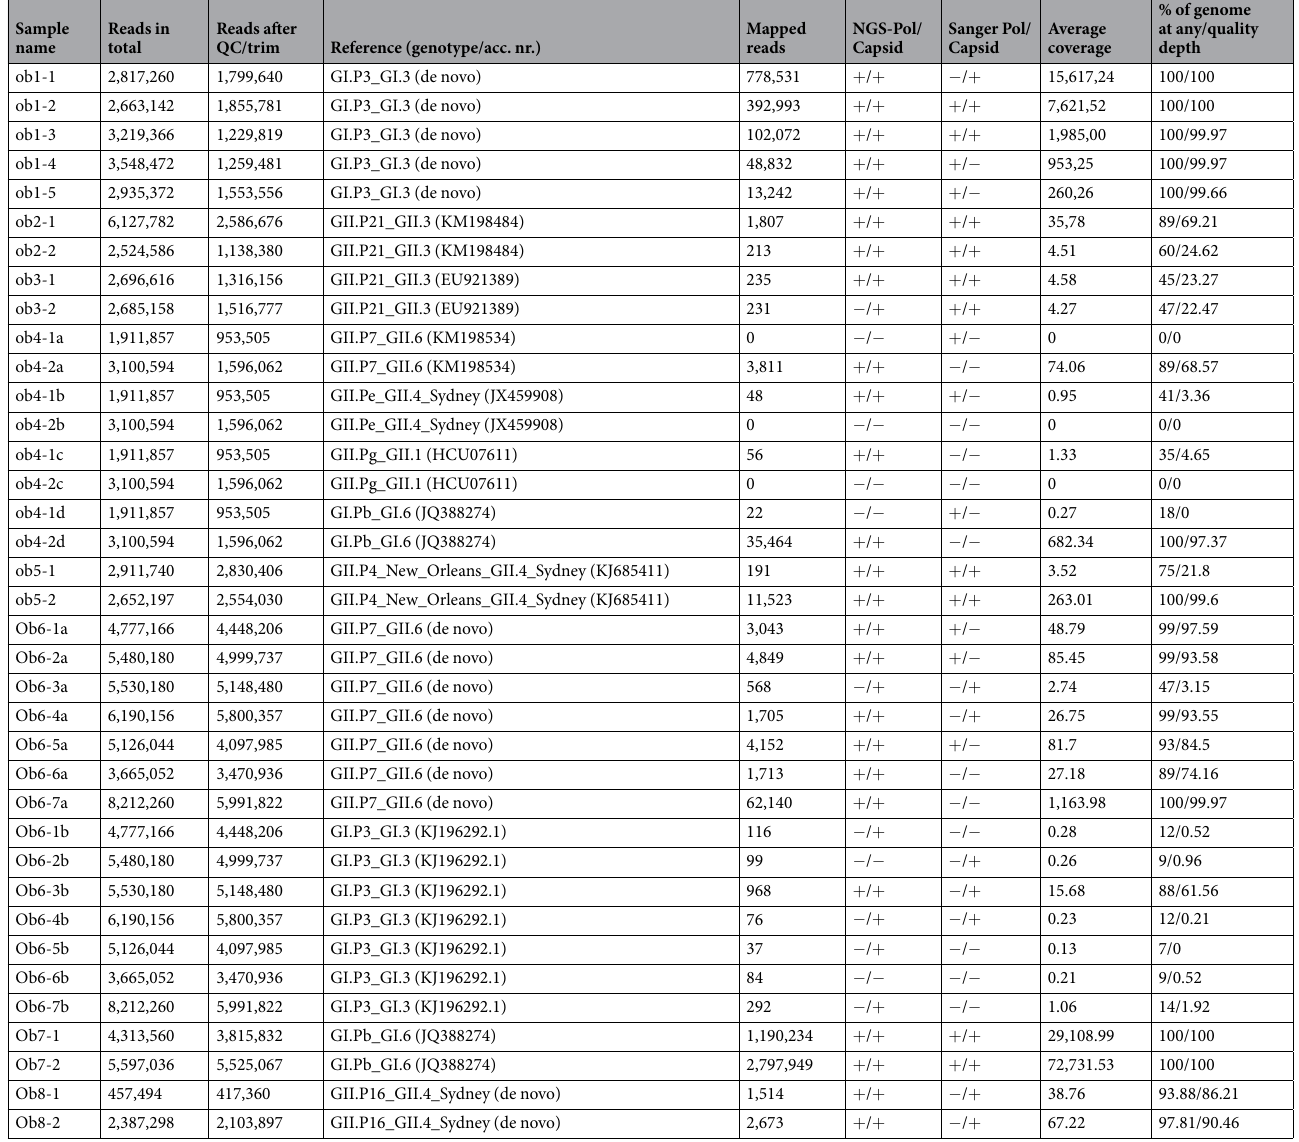
Table 2. Summary of sequencing, mapping and genotyping results of outbreak samples. Legend: Column 1: Sample name. Samples with identical numbers but different letters at the end are identical, but were mapped to different genotype reference sequence., Column 2: Total number of reads obtained before QC and trimming, Column 3: Total number of reads after quality trimming and filtering, Column 4: Genotype of NoV